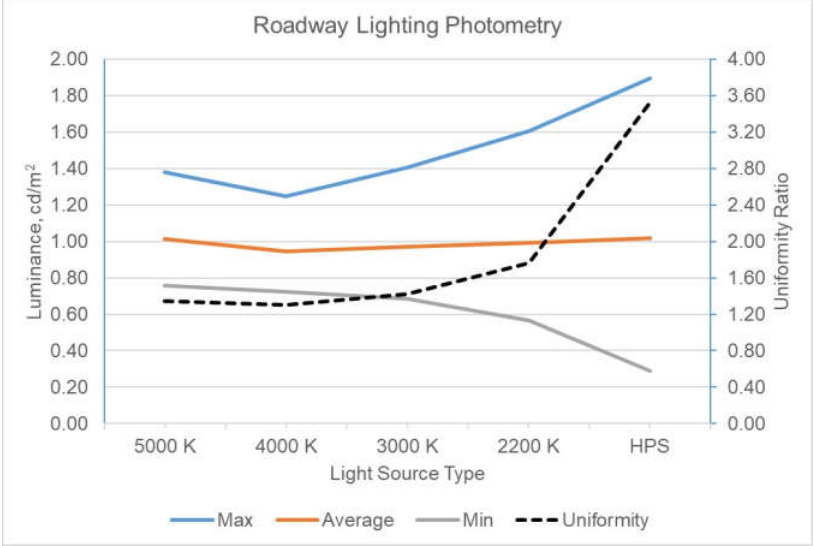
Figure 17. Roadway photometry by